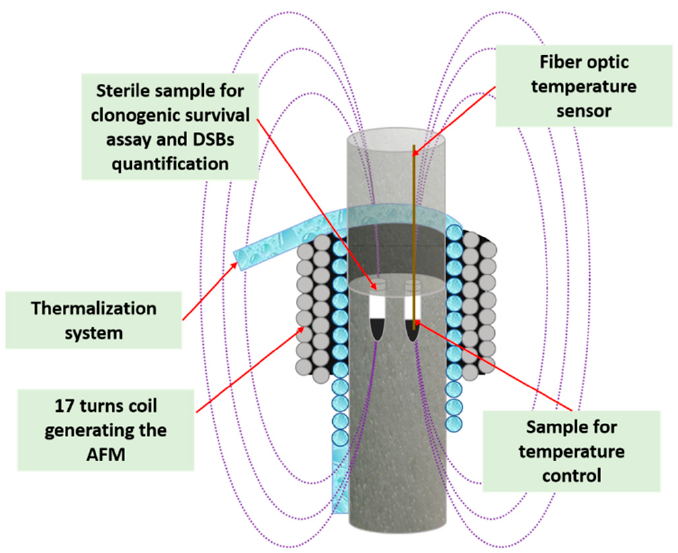
Figure 3. Representation of the hyperthermia setup. A thermalization system (bath heating) circulates water around the two sample vials, one sterile for the clonogenic survival assay and DSBs detection, and one for the temperature registration by a fiber optic probe.